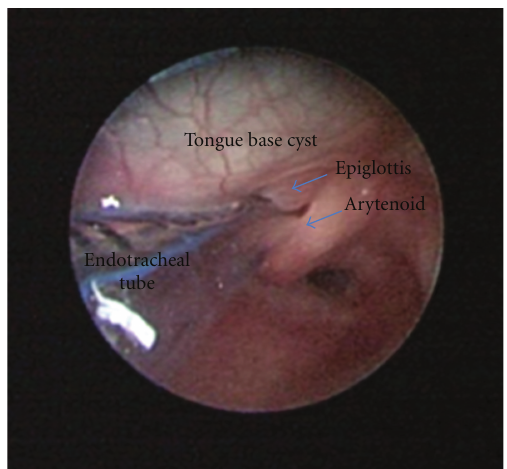
Figure 1: Endoscopic view showing the tongue base cyst and its contact with the larynx.